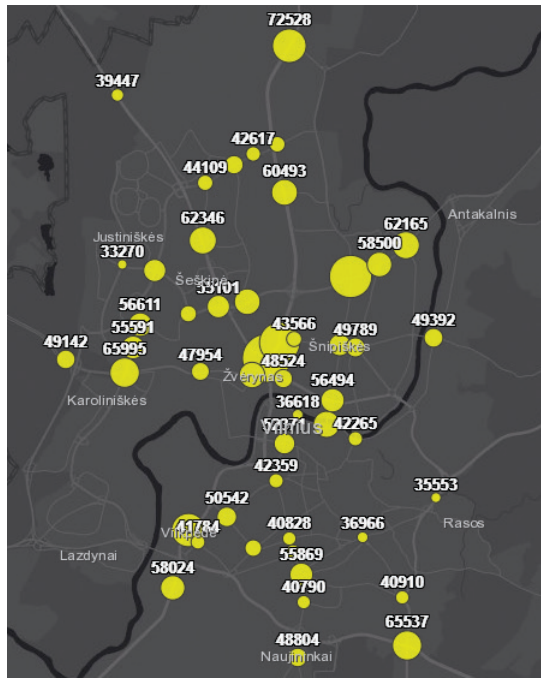
Figure 4. The map of intersections with high traffic volume in 2019